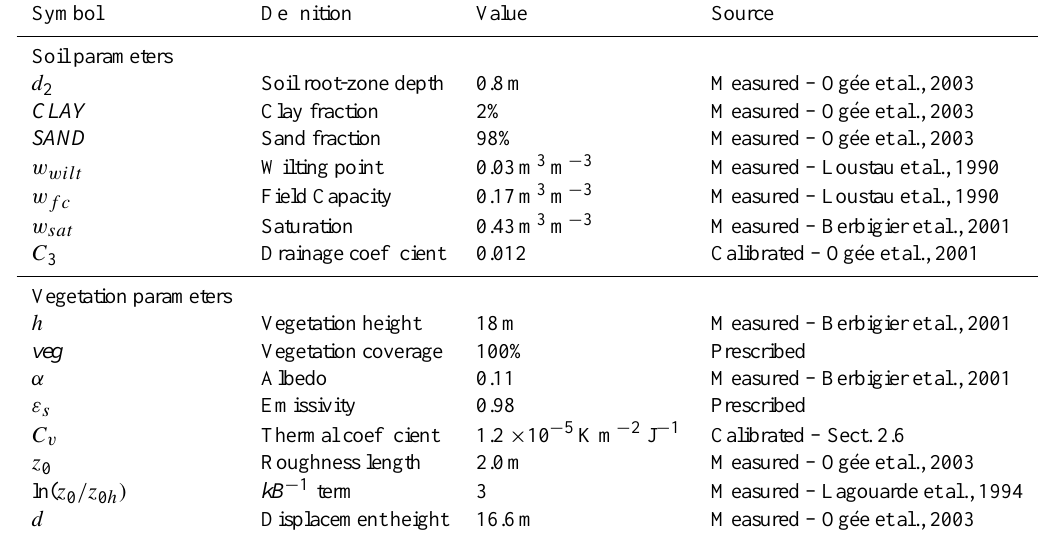
Table 1. The ISBA scheme soil and vegetation structure parameters over the Le-Bray forest. The values are either prescribed, measured, or